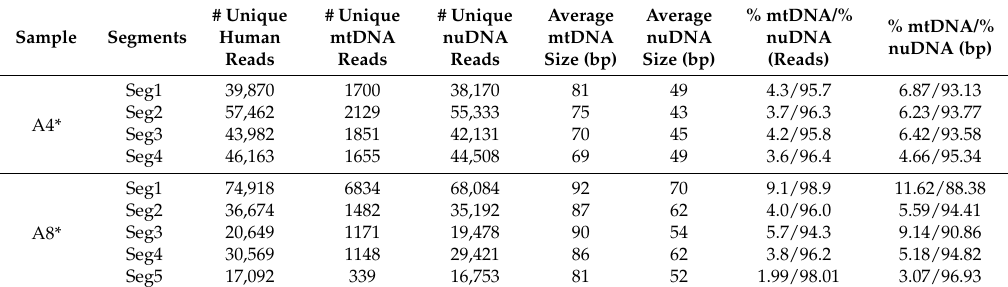
Table 13. Sequencing statistics for two segmented aged